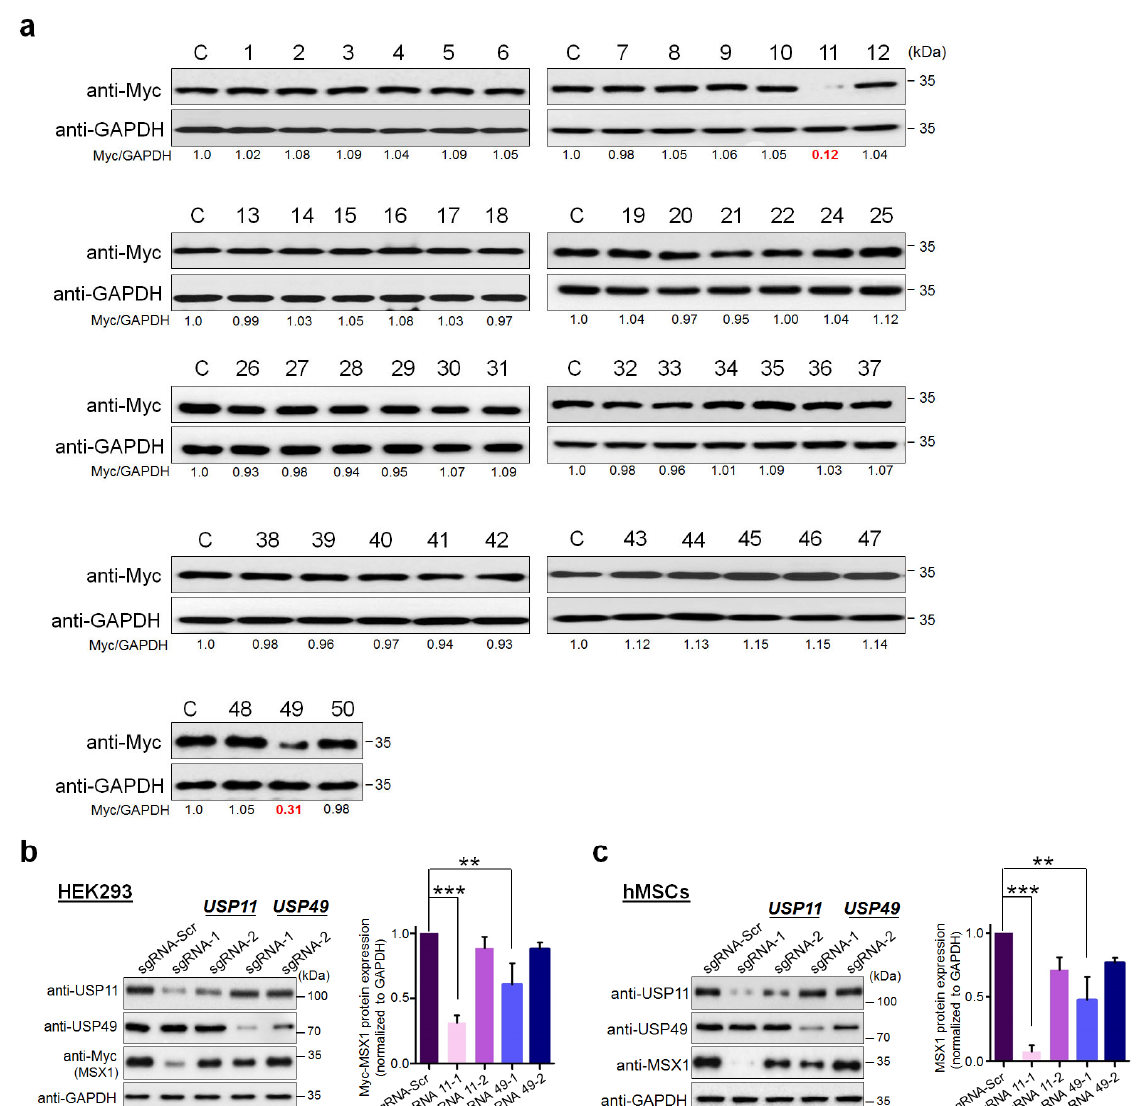
Figure 1. CRISPR-based genome-scale screening of USP sub-family proteins exhibiting a reduction in MSX1 protein levels. ( a ) Screening for DUBs regulating MSX1 was performed using a CRISPR/Cas9-based DUBKO sgRNA kit. HEK293 cells were transfected with Myc-MSX1 and the indicated sgRNAs along with Cas9. Equal concentrations of proteins from the sgRNA kit transfected HEK293 cells were subjected to Western blot analyses. The protein band intensities were estimated using ImageJ software with reference to the GAPDH control band for each individual sgRNA (Myc-MSX1/GAPDH). The loss of USPs leading to the downregulation of the MSX1 protein level is marked in red. ( b ) Myc-MSX1, sgRNAs targeting USP11, or sgRNAs targeting USP49 were transfected in HEK293 cells. The protein band intensity of HEK293 cells transfected with sgRNA1 targeting USP11 showed the highest reduction in MSX1. This experiment was performed in triplicates and band intensities were estimated using ImageJ software with reference to the GAPDH control band and are graphically represented. One-way ANOVA followed by Tukey’s post hoc test was used. Error bars represent ± SD, ** p < 0.001 and *** p < 0.0001. ( c ) The sgRNAs targeting USP11 or sgRNAs targeting USP49 , which potentially regulate endogenous MSX1 protein levels, were transfected in hMSCs along with Cas9. The protein band intensity of hMSCs transfected with sgRNA1 targeting USP11 showed the highest reduction in MSX1. This experiment was performed in triplicates and band intensities were estimated using ImageJ software with reference to the GAPDH control band and are graphically represented. One-way ANOVA followed by Tukey’s post hoc test was used. Error bars represent ± SD, ** p < 0.001, and *** p <